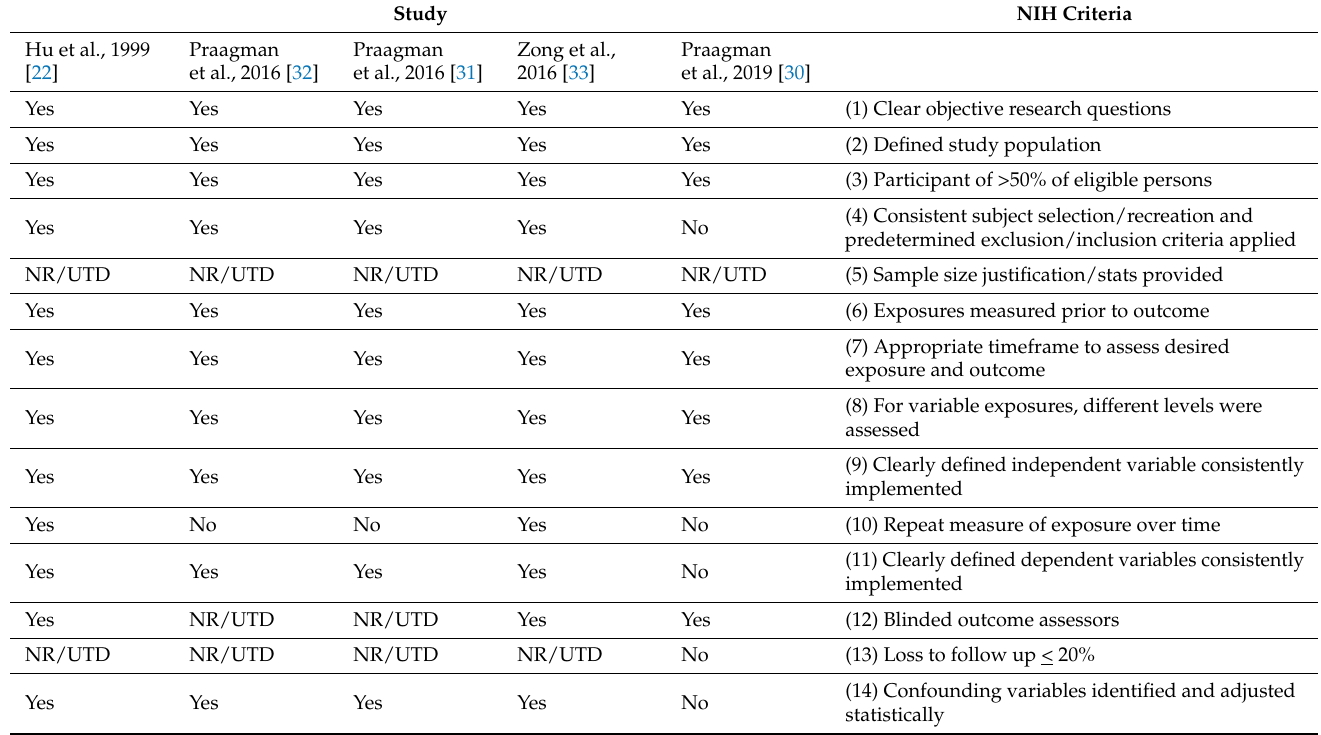
Table created using Study Quality Assessment Tools | NHLBI, NIH. https://www.ncbi.nlm.nih.gov/pubmed/ NR/UTD (Accessed on 12 October 2022), not reported or unable to